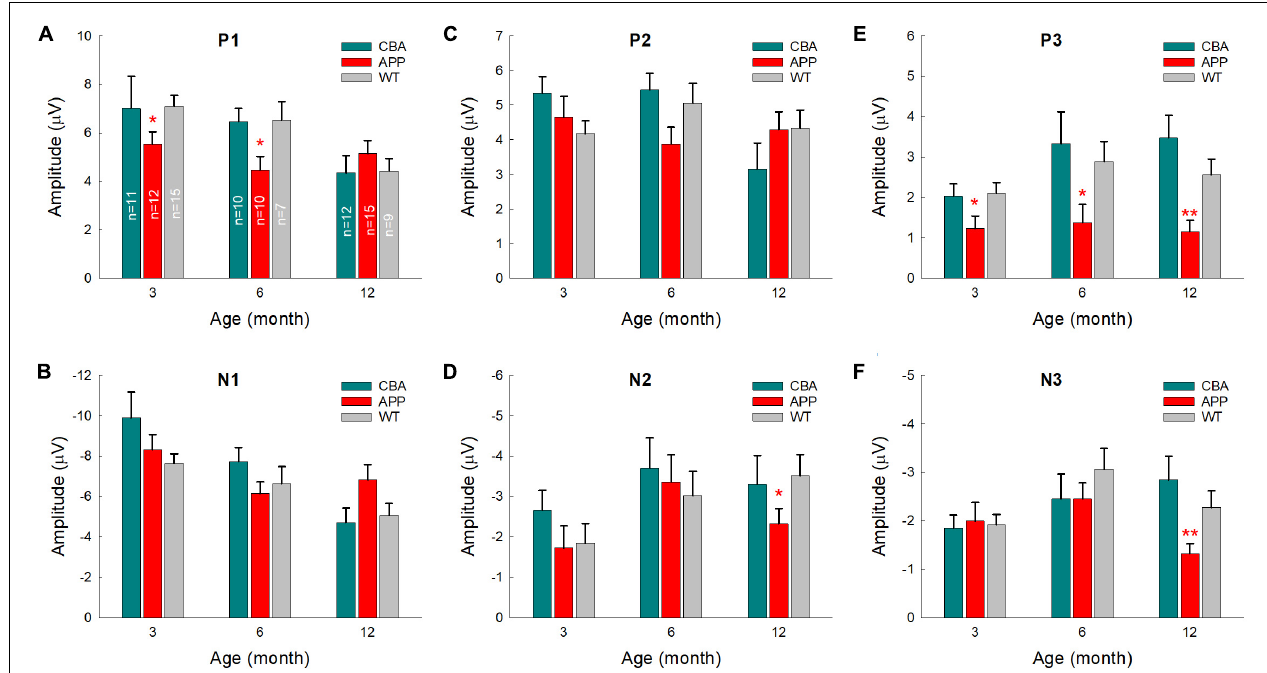
FIGURE 6 | Comparison of AECP changes in CBA/CaJ mice, APP/PS1 AD mice, and WT littermate mice. Peak name is presented at the top middle place in each panel. Animal numbers in each group are presented within the bars in panel (A) . Panel (E) shows that peak P3 in the AD mice has a significant reduction in comparison with those in CBA and WT littermate mice. * p < 0.05, ** p < 0.01, one-way ANOVA with a Bonferroni correction.